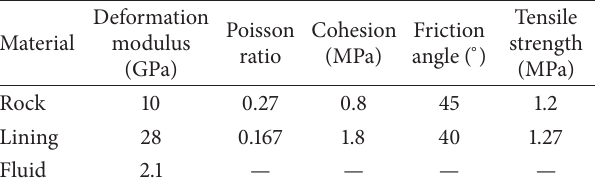
Figure 4: Local finite element model of tunnel structure. Table 1: Mechanical parameters of materials.